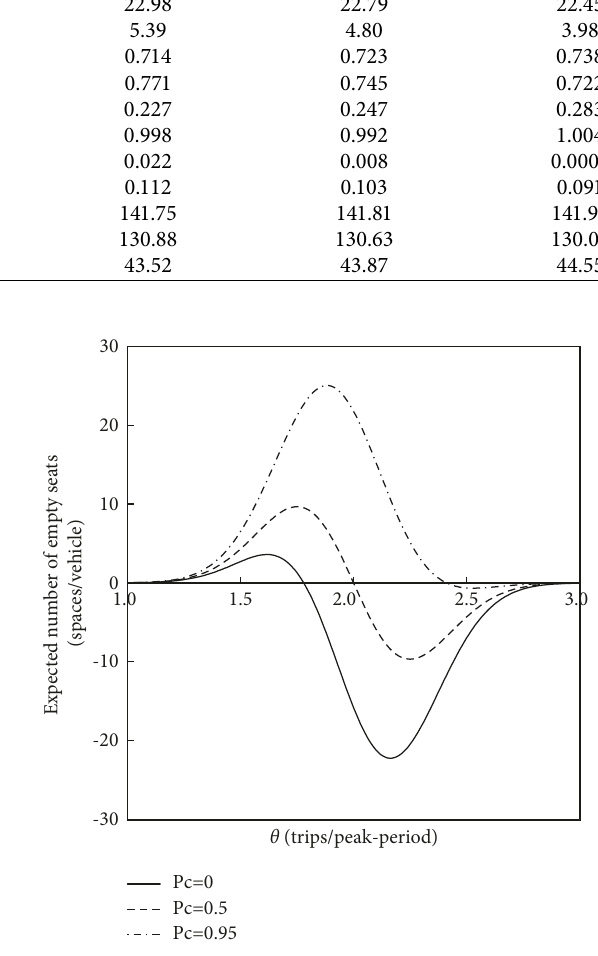
Figure 3: Distribution of the number of the expected empty